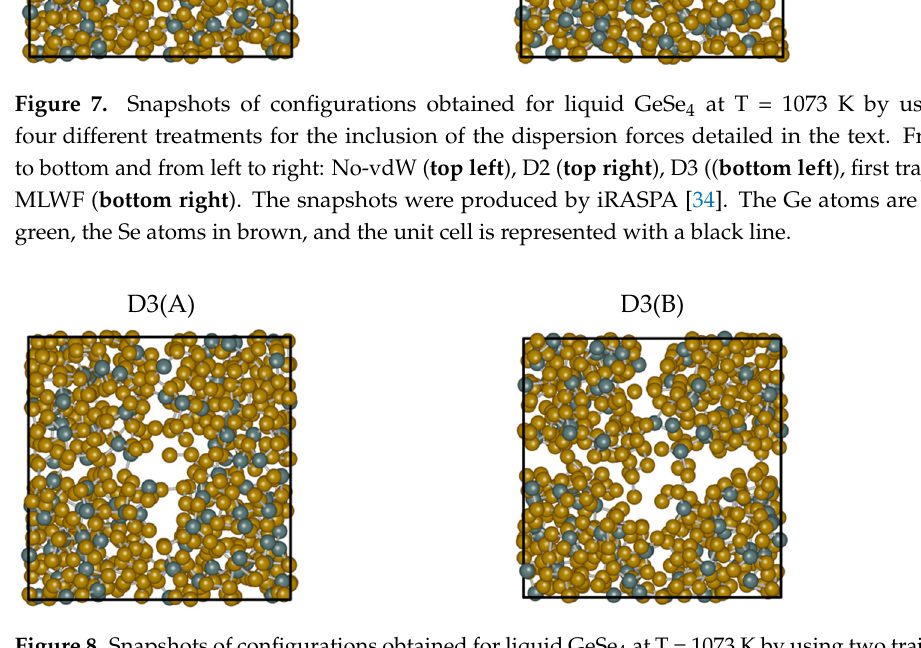
Figure 8. Snapshots of configurations obtained for liquid GeSe 4 at T = 1073 K by using two trajectories for the D3 case, D3(A), and D3(B), the second being produced from the final state of D2. Left side : snapshot extracted from the D3(A) trajectory. Right : snapshot extracted from the D3(B) trajectory. The snapshots were produced by iRASPA [34]. The Ge atoms are in dark green, the Se atoms in brown, and the unit cell is represented with a black line.